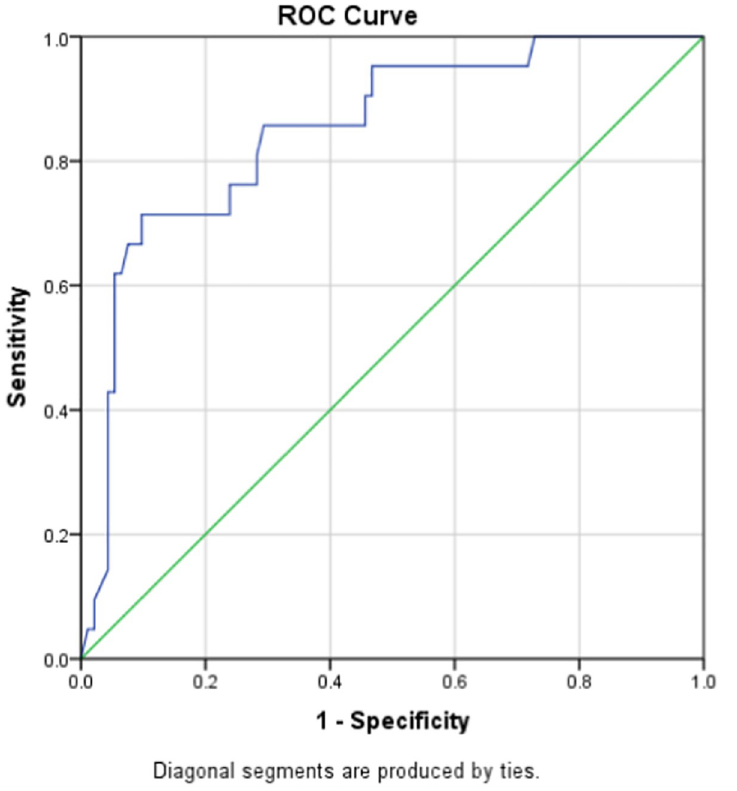
Fig 2. ROC curve for D-dimer as a predictor of in-hospital mortality in